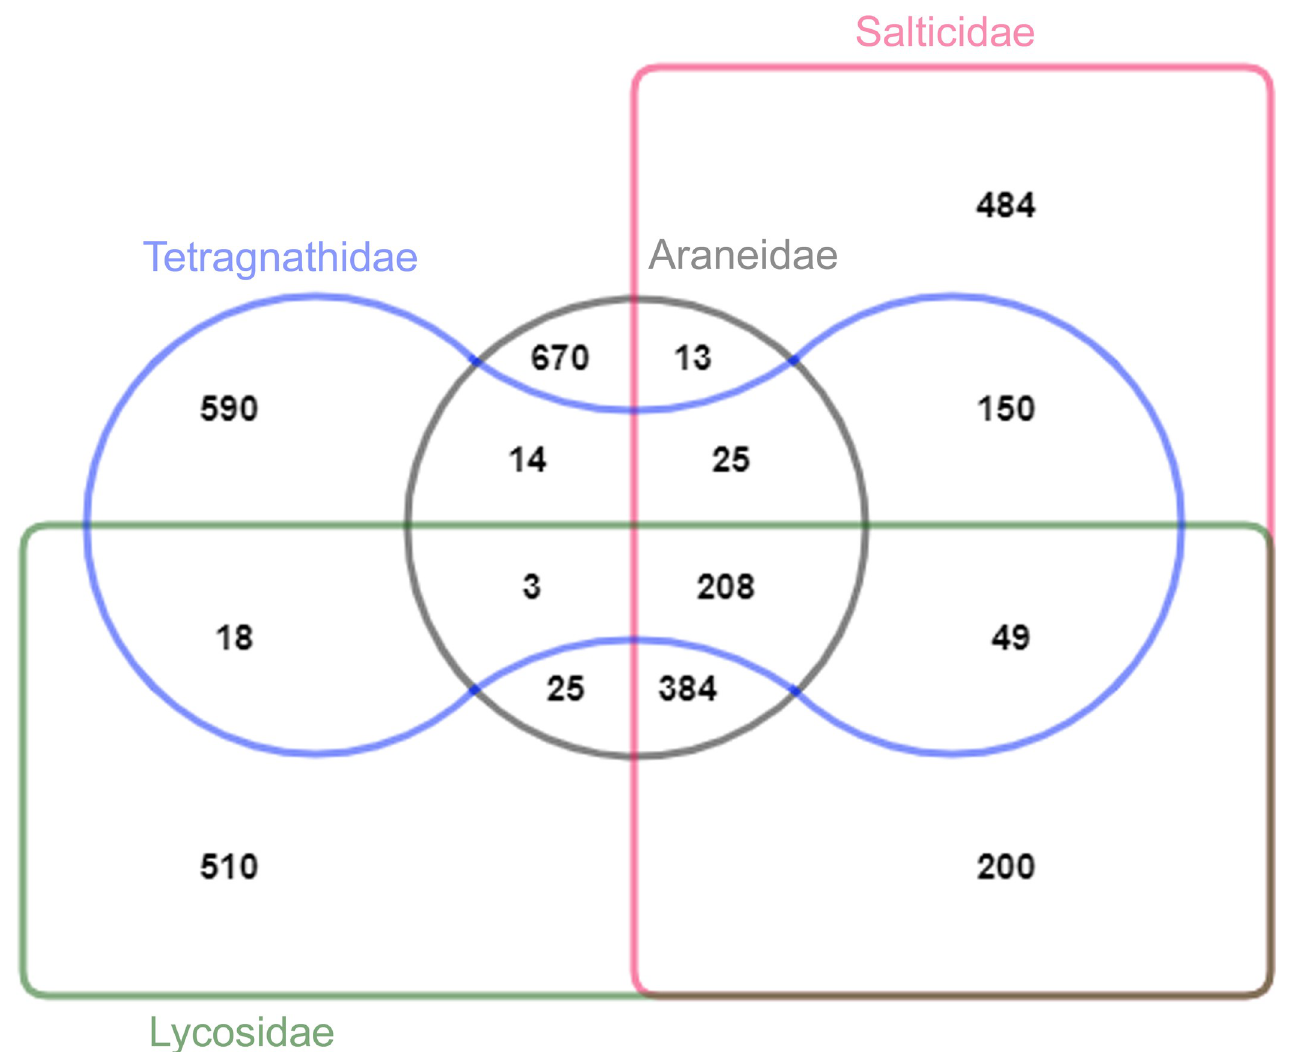
Fig 1. Venn diagram illustrates overlap of ASVs in gut bacterial diversity among the four spider